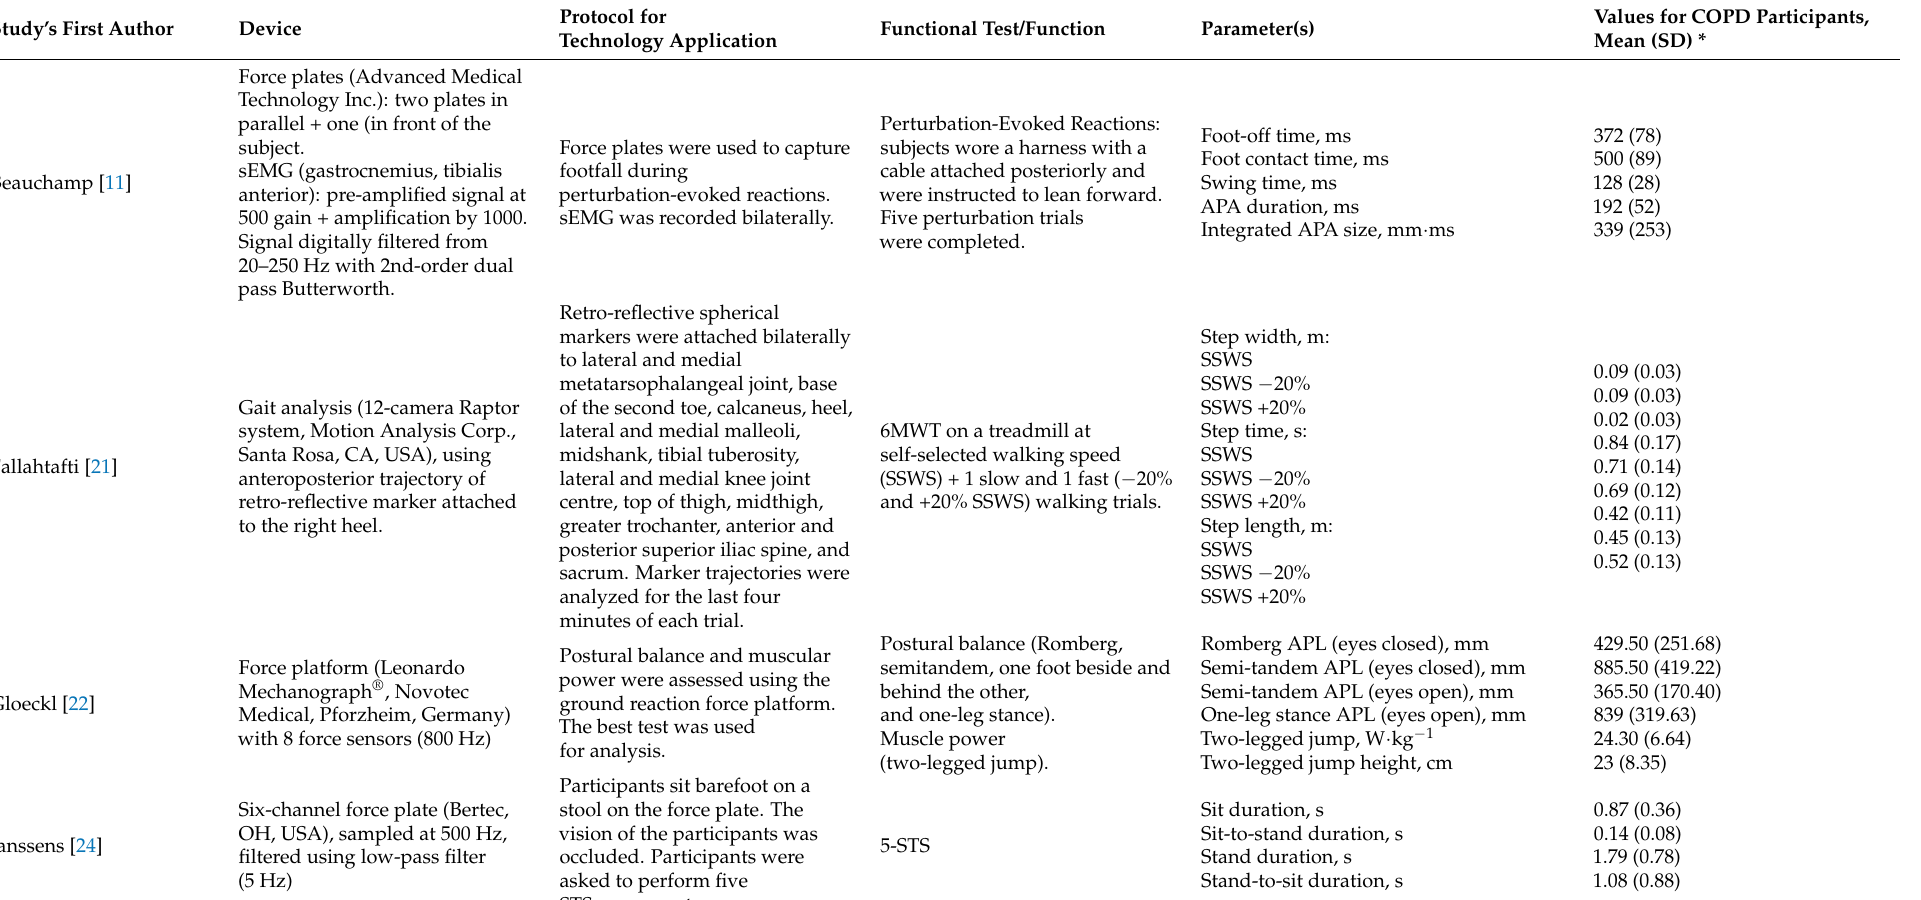
Table 3. Non-wearable devices employed and functions/parameters estimated in application